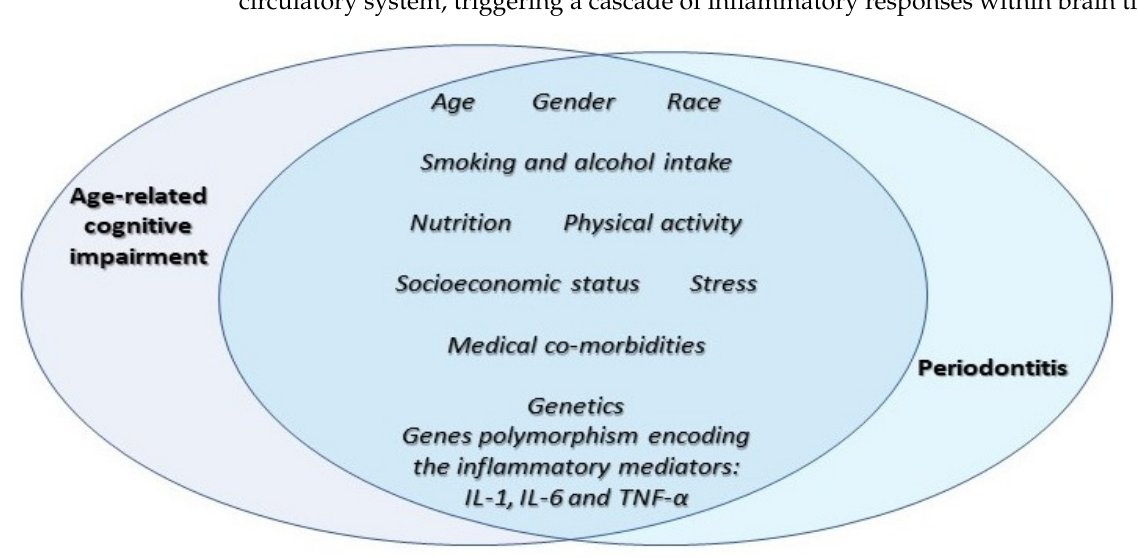
Figure 2. Shared risk factors and predictors for periodontitis and age-related cognitive impairment. Lifestyle, environmental determinants, and genetic predisposition.